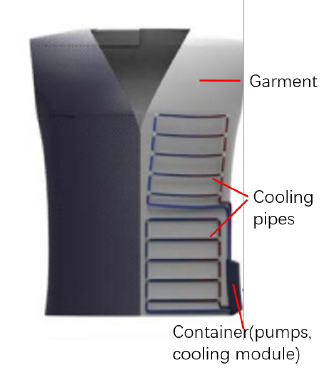
Figure 1. Cooling system for